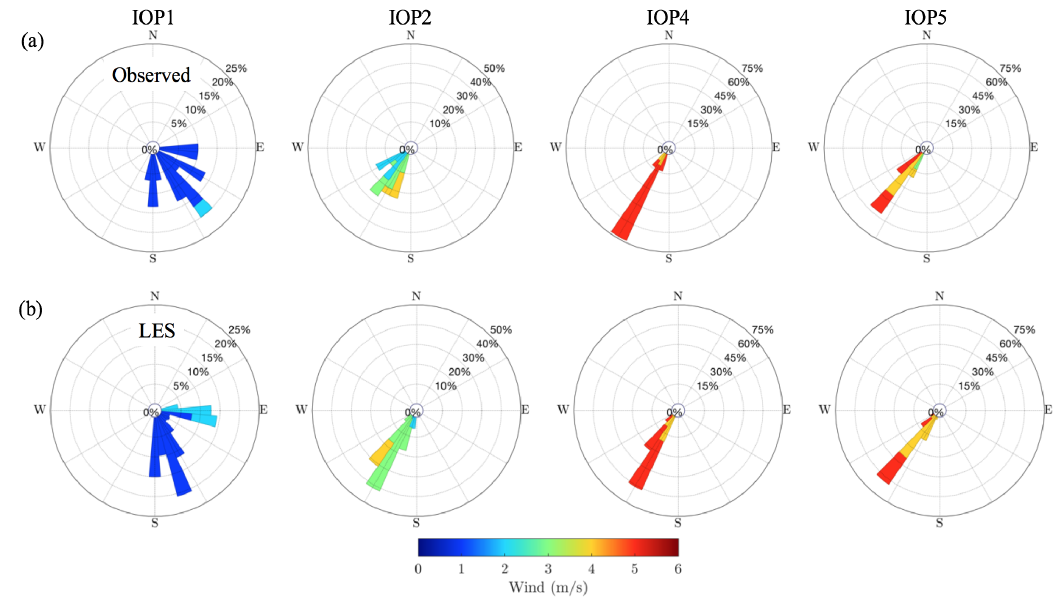
Figure 8. Wind Rose comparison between ( a ) observed and ( b ) LES simulated 15-m wind directions. From left to right: IOP1, IOP2, IOP4 and IOP5.